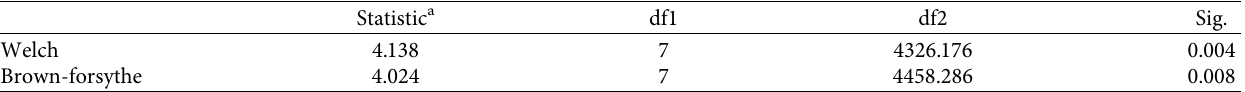
Table 4: Results of robust tests of equality of means on personality development qualities in Madras Group. Statistic a df1 df2 Sig.